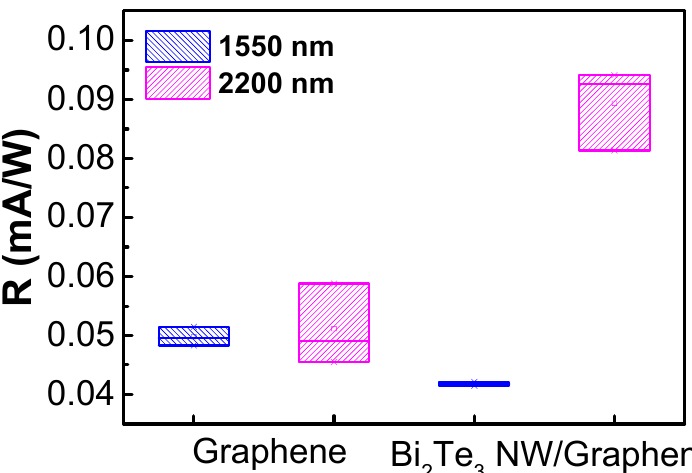
Figure 7. Short-wavelength infrared (SWIR) photoresponsivity comparison for both the graphene and Bi 2 Te 3 NWs/graphene photodetector. Light power was 8 mW for a 1550 nm wavelength and 13 mW for 2200 nm. The device channel width and length were 5 and 3 µ m, respectively.